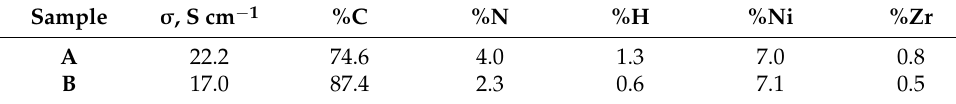
Table 6. Elemental analysis and electrical conductivity of samples A and B